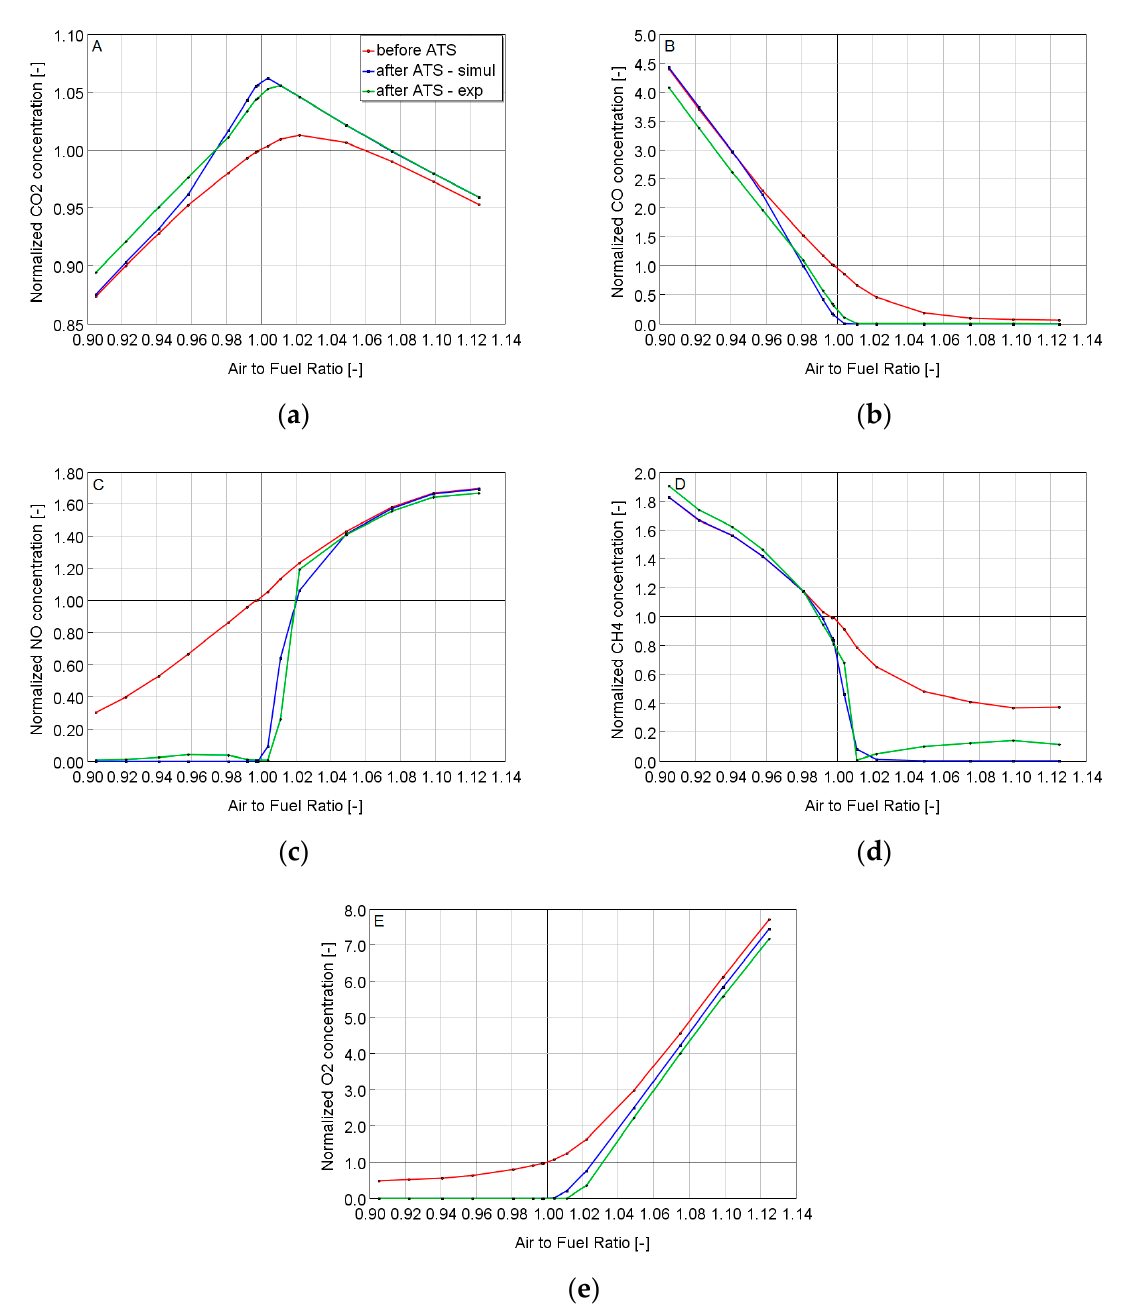
Figure 6. SS tests at 100% Load. Gas Temp. ≈ 760 ◦ C. (1900 RPM,100% load). ( a ) Num / Exp. CO 2 engine out and tailpipe concentration. ( b ) Num / Exp. CO engine out and tailpipe concentration. ( c ) Num / Exp. NO engine out and tailpipe concentration ( d ) Num / Exp. CH 4 engine out and tailpipe concentration. ( e ) Num / Exp. O 2 engine out and tailpipe concentration.